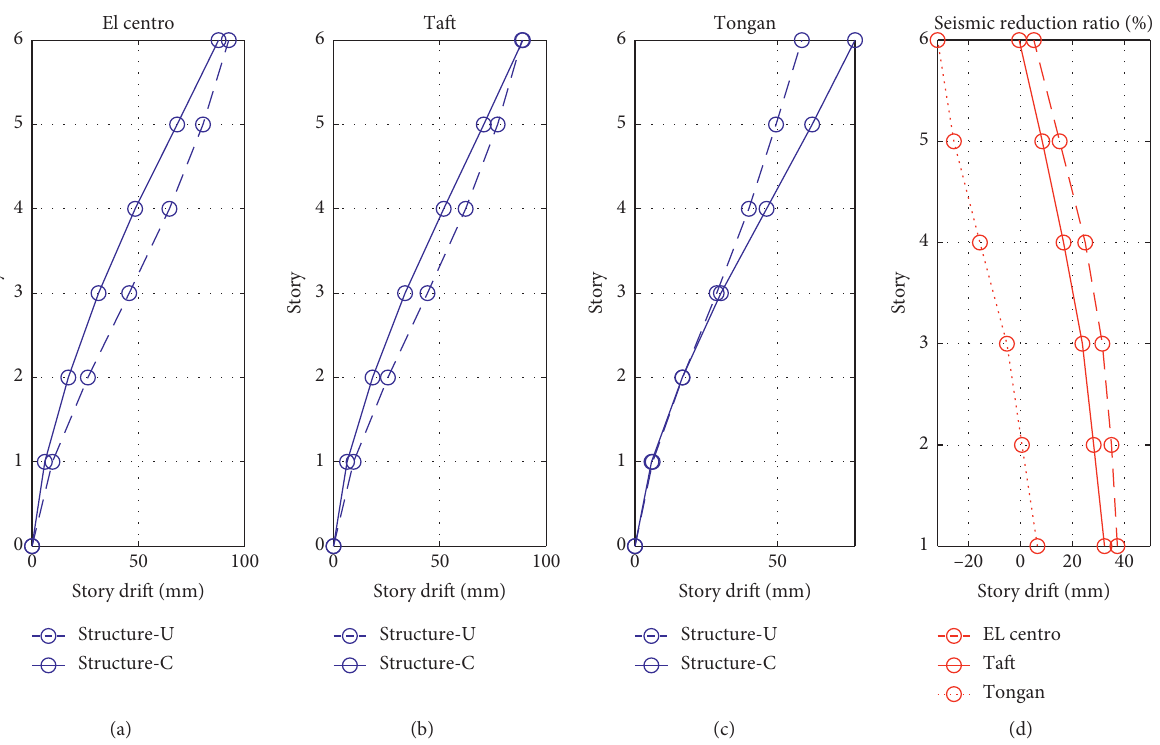
Figure 17: Story drift and its seismic reduction